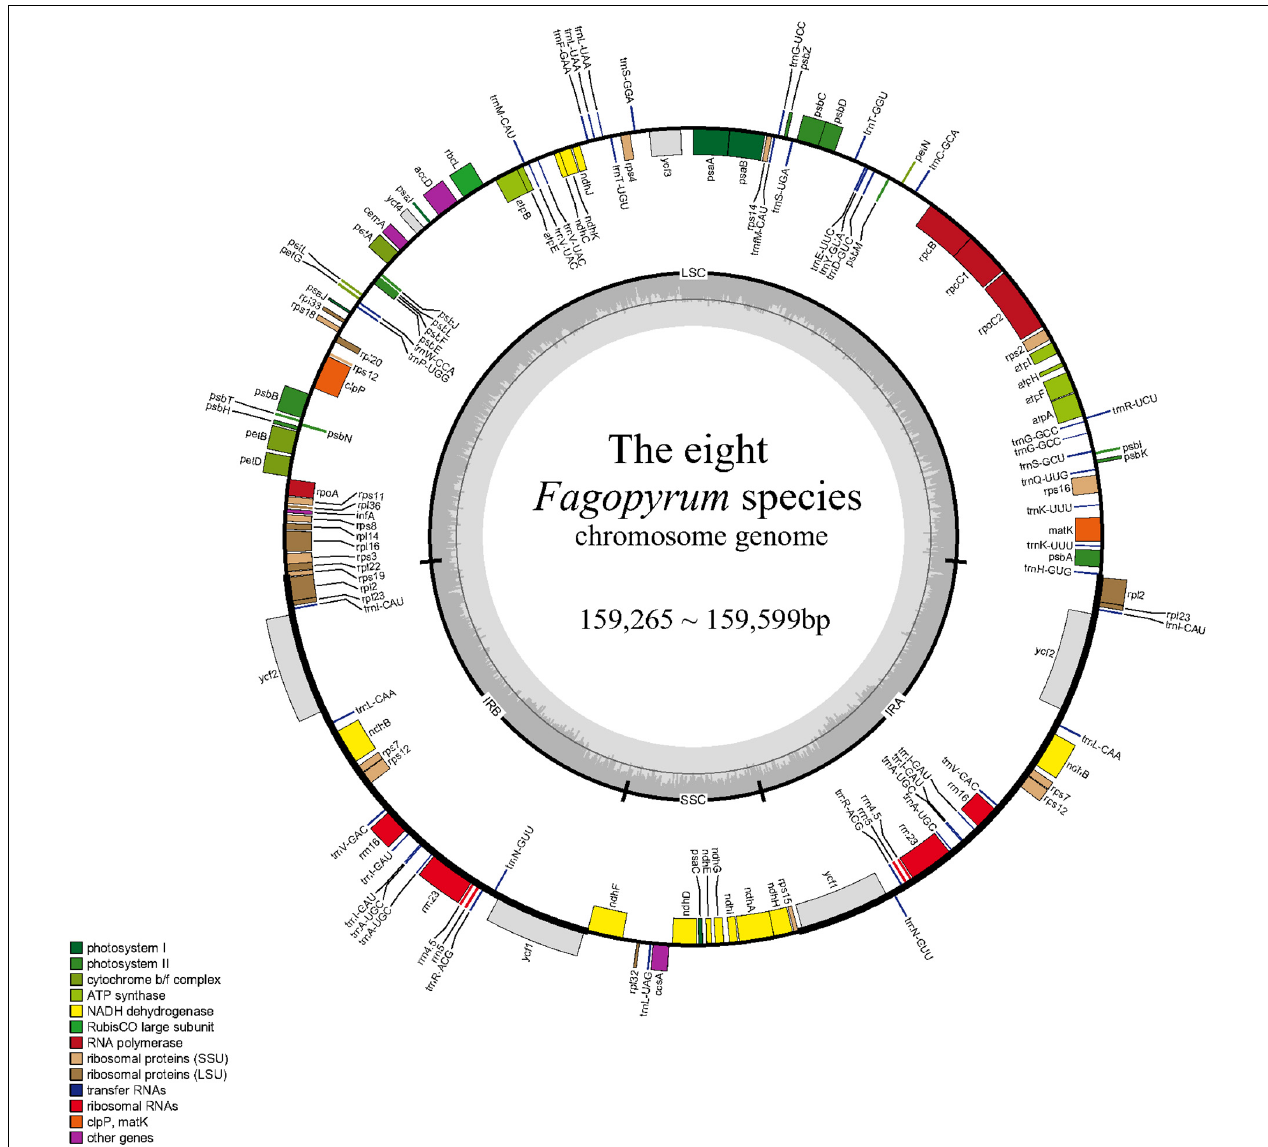
FIGURE 2 | Gene map of the eight Fagopyrum species. The genes shown outside of the circle are transcribed clockwise, while those inside are transcribed counterclockwise. Genes belonging to different functional groups are color-coded. The dashed area in the inner circle indicates the GC content of the chloroplast